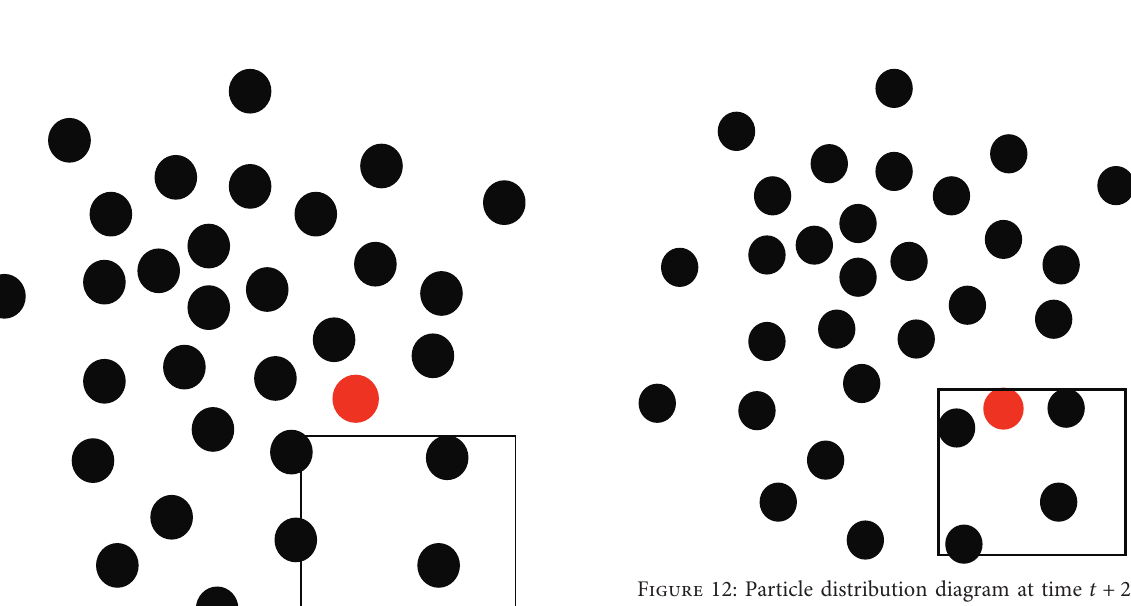
Figure 11: Particle distribution diagram at time t + 2.